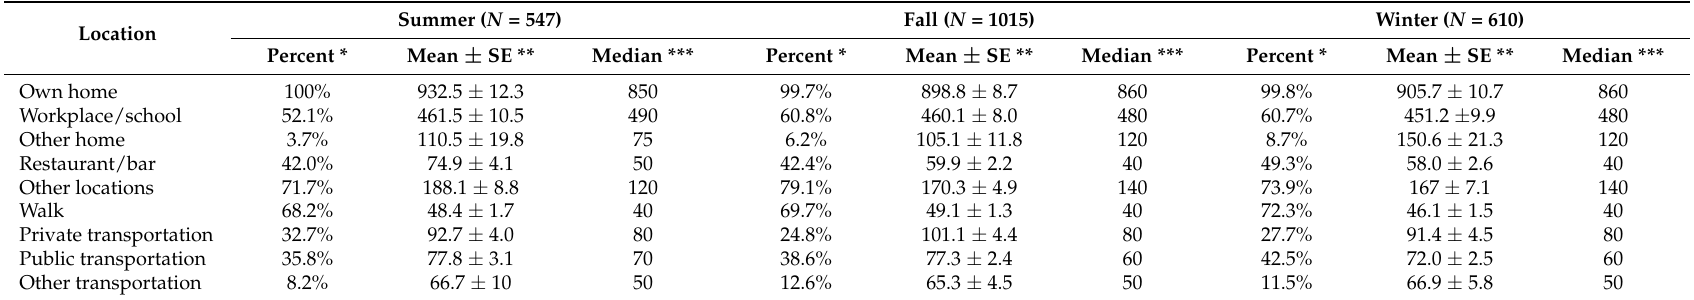
Table 3. The amount of time spent by those who visited nine locations in Busan over three seasons.